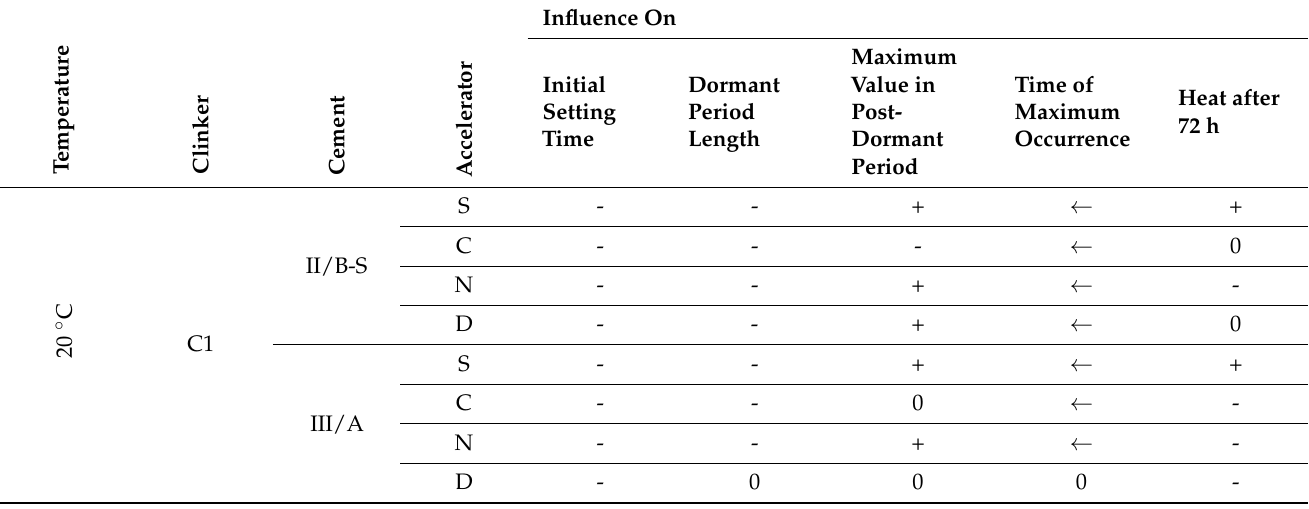
Table 8. Effects of accelerators on hydration heat and initial setting time in comparison to non- modified